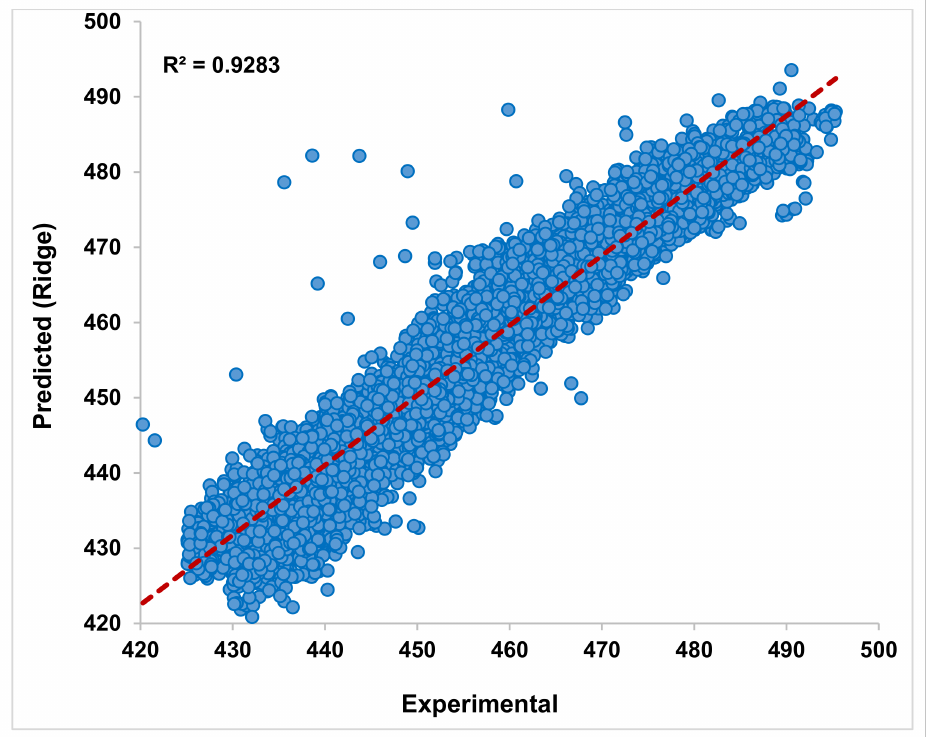
Figure 3. Training results of Ridge regressor with α = 0 with R 2 = 0.9283.